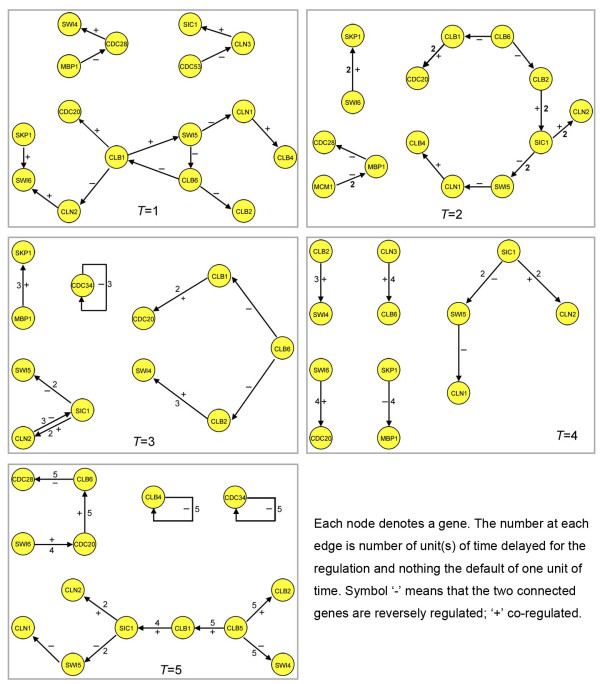
The time-delayed gene regulatory networks for yeast cell cycling.